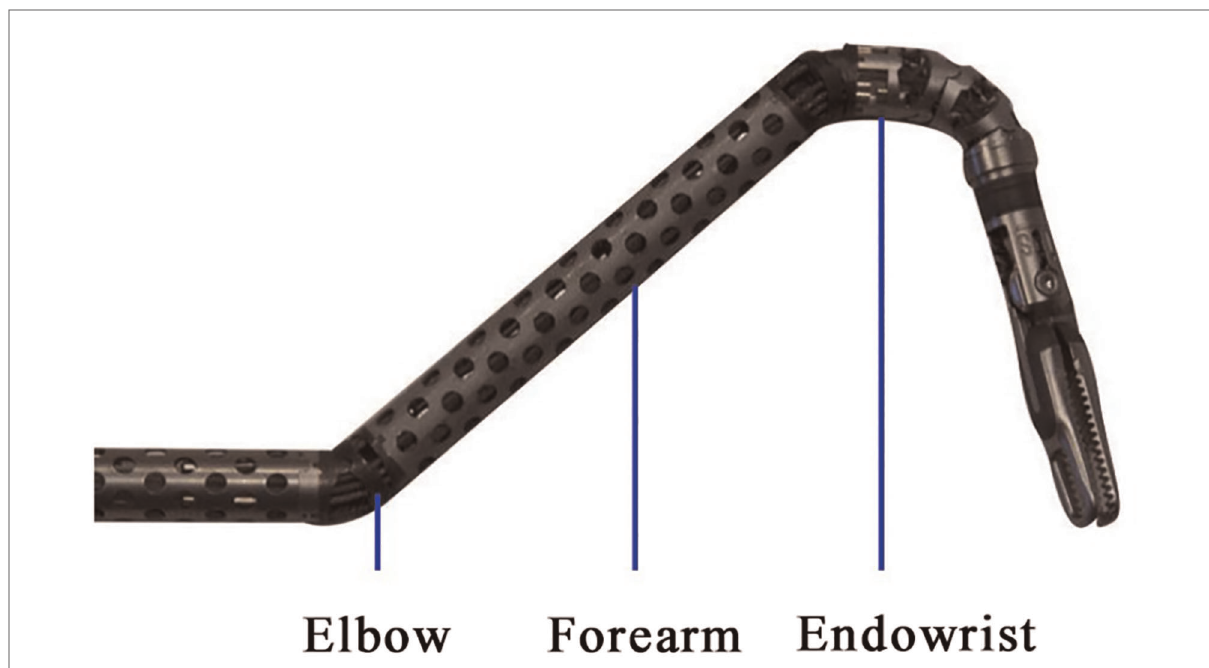
FIGURE 2 Demonstration of the fl exible double-jointed instrument. The movement of the “ elbow ” joint ensures that the lens does not con fl ict with the two